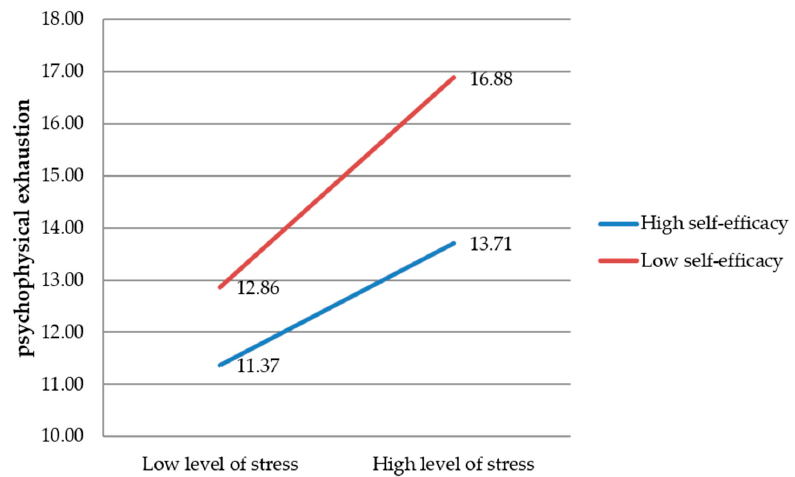
Figure 3. The impact of the sense of self-efficacy on the relationship between the level of perceived stress and psychophysical exhaustion.